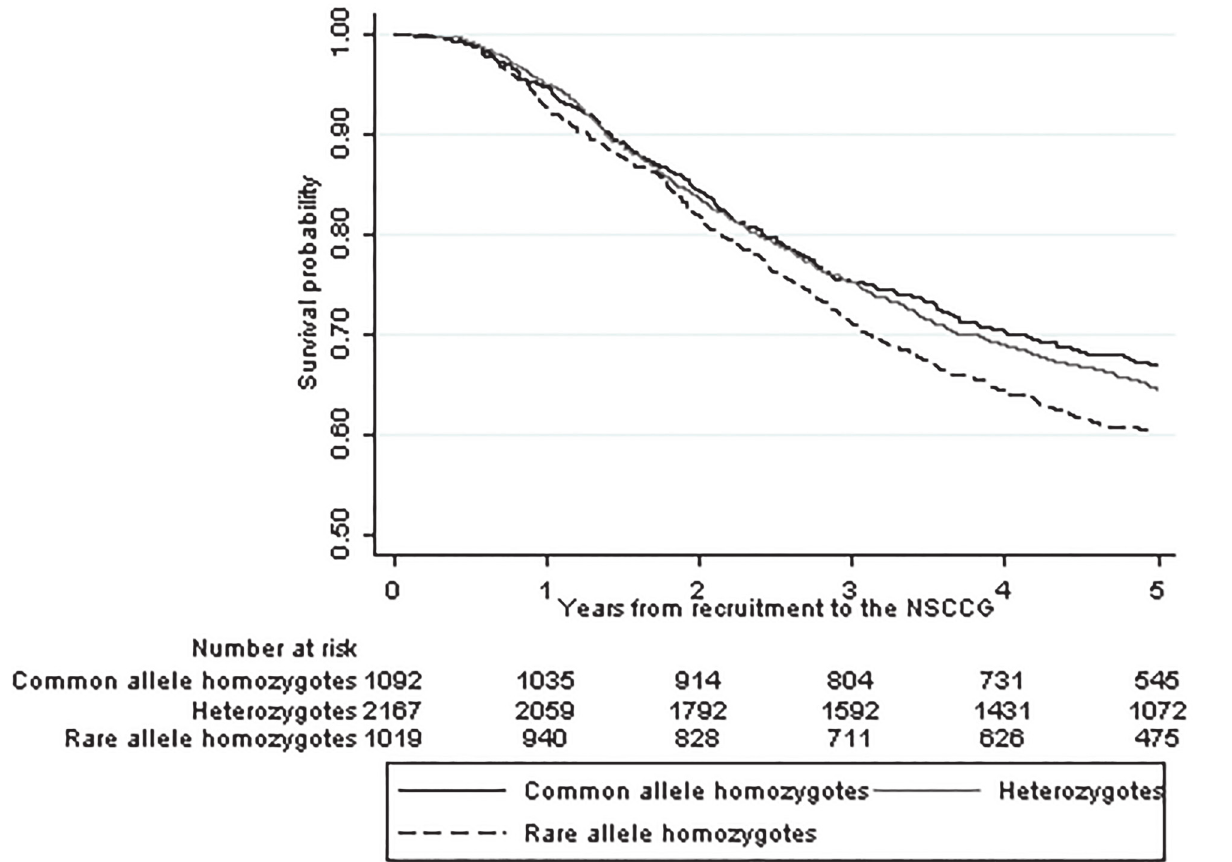
Fig 2. Kaplan Meier survival curves for SNP